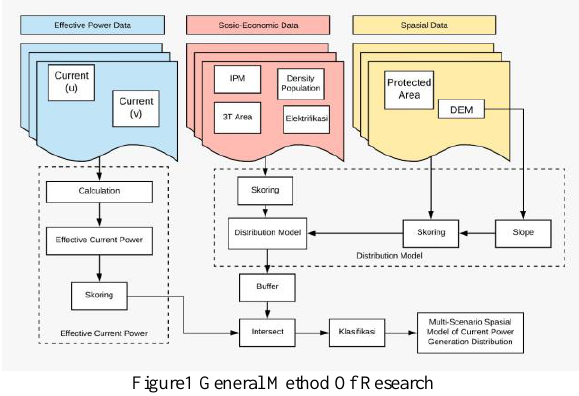
Figure1 General Method Of Research 2.2.1 ModelingBased on Spatial Aspects